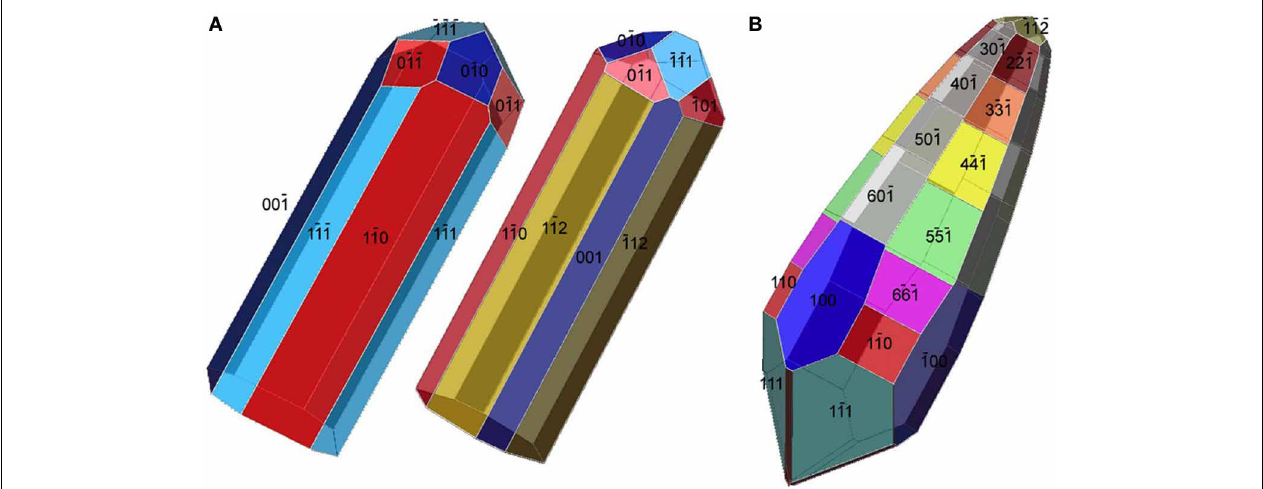
FIGURE 5 | Tentative morphological models for the elongated magnetosomes in Figures 4B,C. (A) Two possible morphologies for the magnetosome in Figure 4B . The curving of the magnetosome is not taken